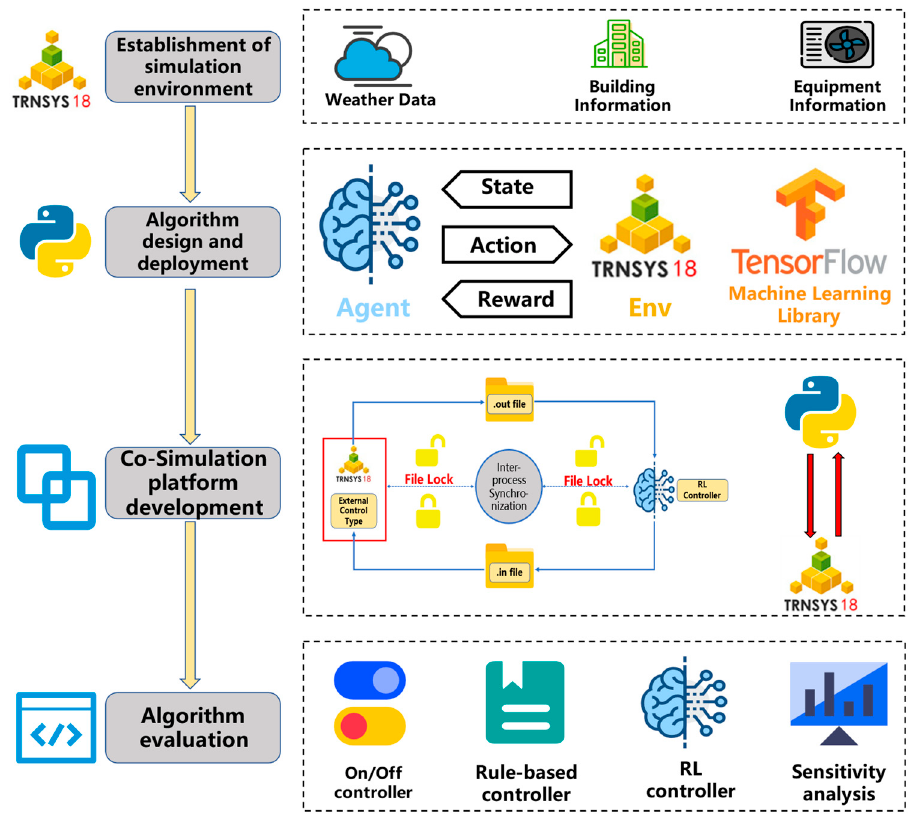
Figure 1. Schematic diagram of the overall technical approach.